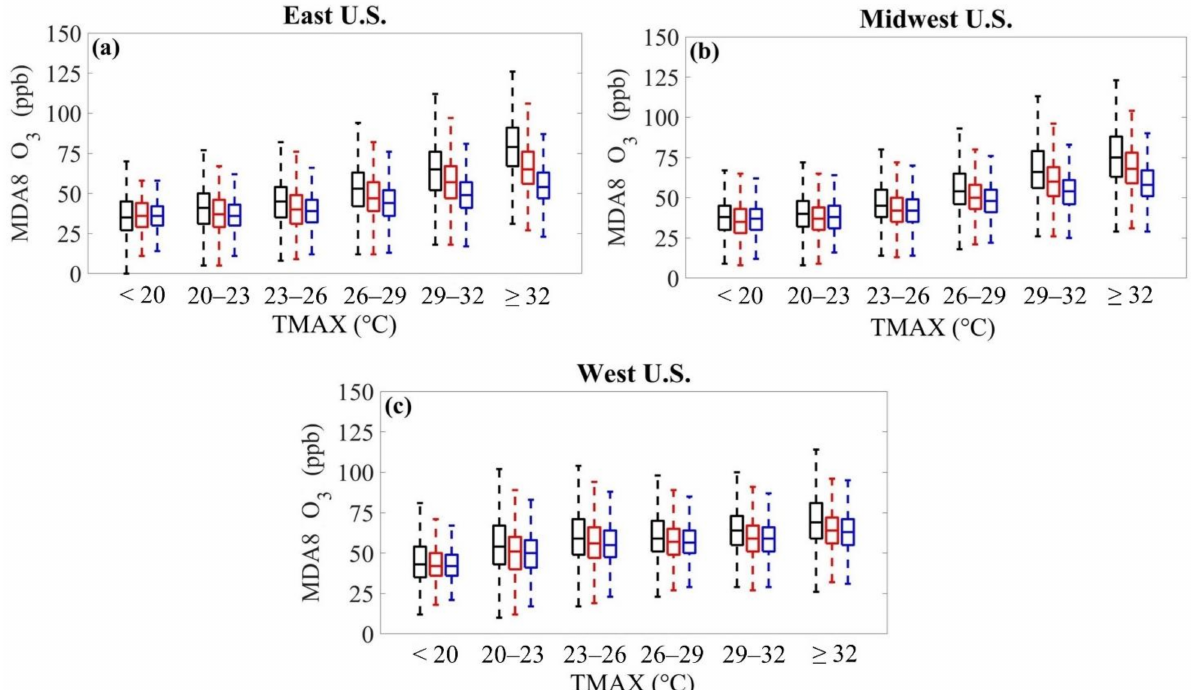
Figure 3. Maximum daily 8-h average (MDA8) O 3 (ppb) versus daily maximum temperature (TMAX; ◦ C) for six temperature bins for urban nonattainment areas (NAAs) in ( a ) the eastern U.S., ( b ) the midwestern U.S., and ( c ) the western U.S. This relationship was examined across three time intervals: 1995–2003 (black), 2004–2012 (red), and 2013–2020 (blue). All boxplots were generated using coincident MDA8 O 3 and TMAX data collected from May to September. The top and bottom whiskers denote the maximum and minimum MDA8 O 3 concentrations, respectively, that are not considered outliers, the central rectangles span the 25th percentile to the 75th percentile, and the horizontal lines within the central rectangles represent the median MDA8 O 3